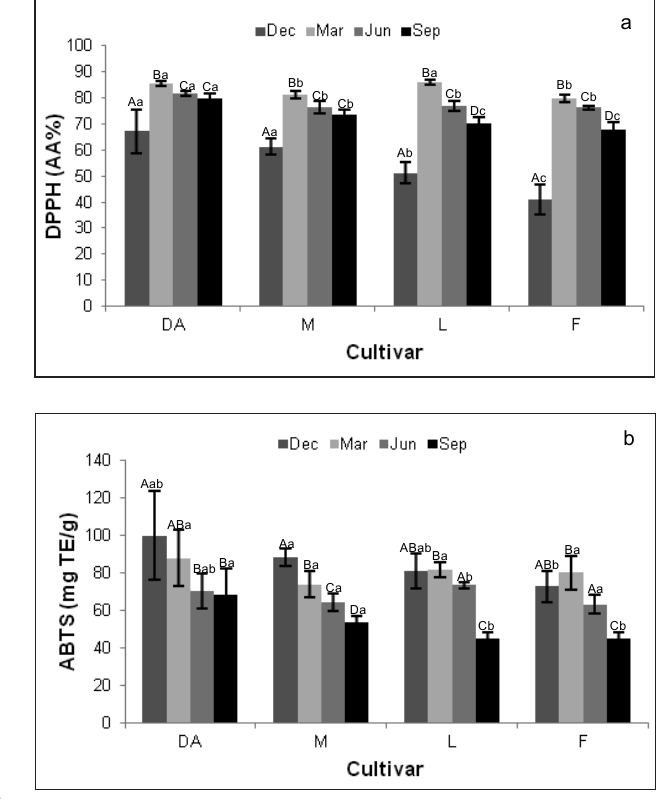
Fig. 5: Antioxidant activity determined by (a) DPPH assay (AA%, mean values) and (b) ABTS assay (mg TE/g, mean values) in olive leaves harvested in different periods from different cultivars. Error bars in- dicate SD of the means (n = 5). Means with different capital letters indicate significant differences ( P ≤ 0.05) among months within the same olive cultivar. Means with different lower case letters indicate significant differences ( P ≤ 0.05) among olive cultivars within the same month. Abbreviations of olive cultivars and harvesting periods have been reported in Fig.